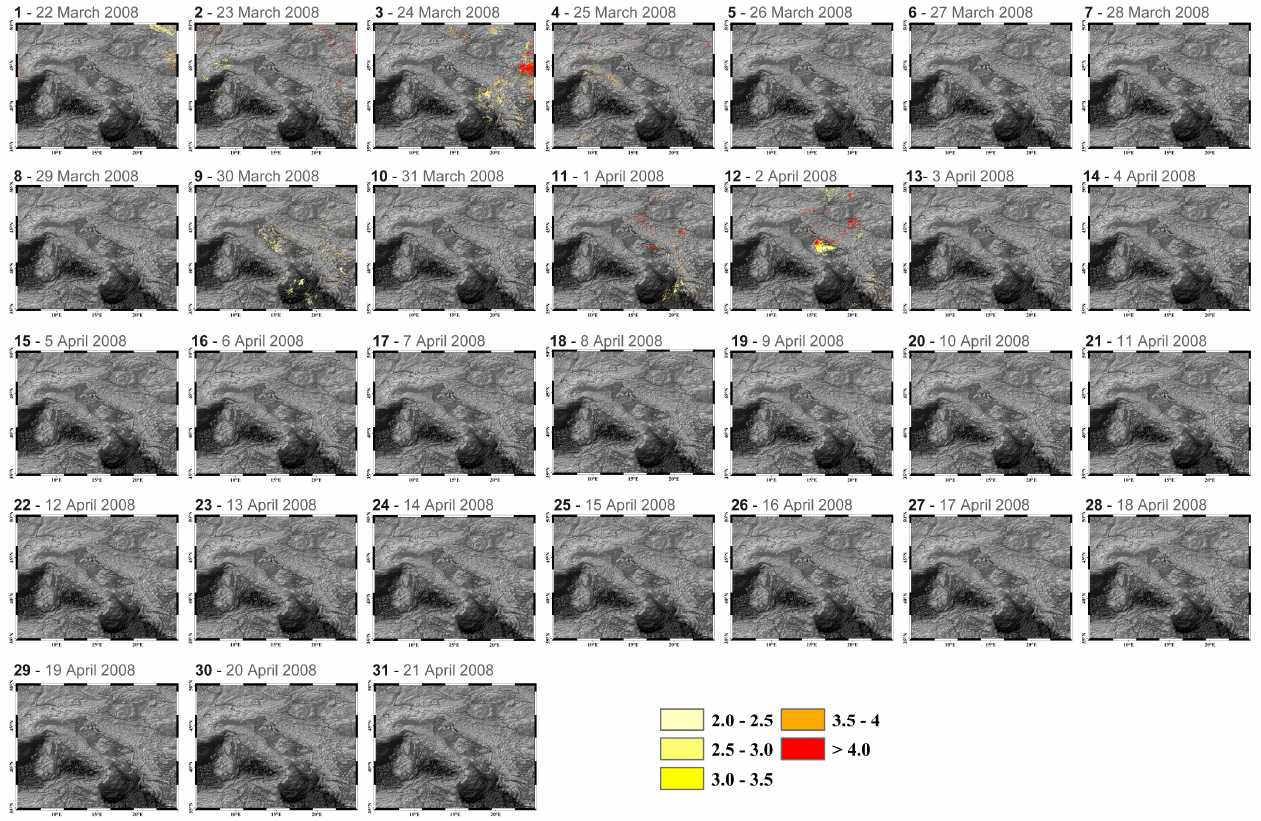
Figure 7 Results of the RETIRA index computation on the investigated area from 22 March, 2008 to 21 April, 2008 using AATSR BT data (Nadir view). 2 Fig. 7. Results of the RETIRA index computation on the investigated area from 22 March 2008 to 21 April 2008 using AATSR BT data (nadir